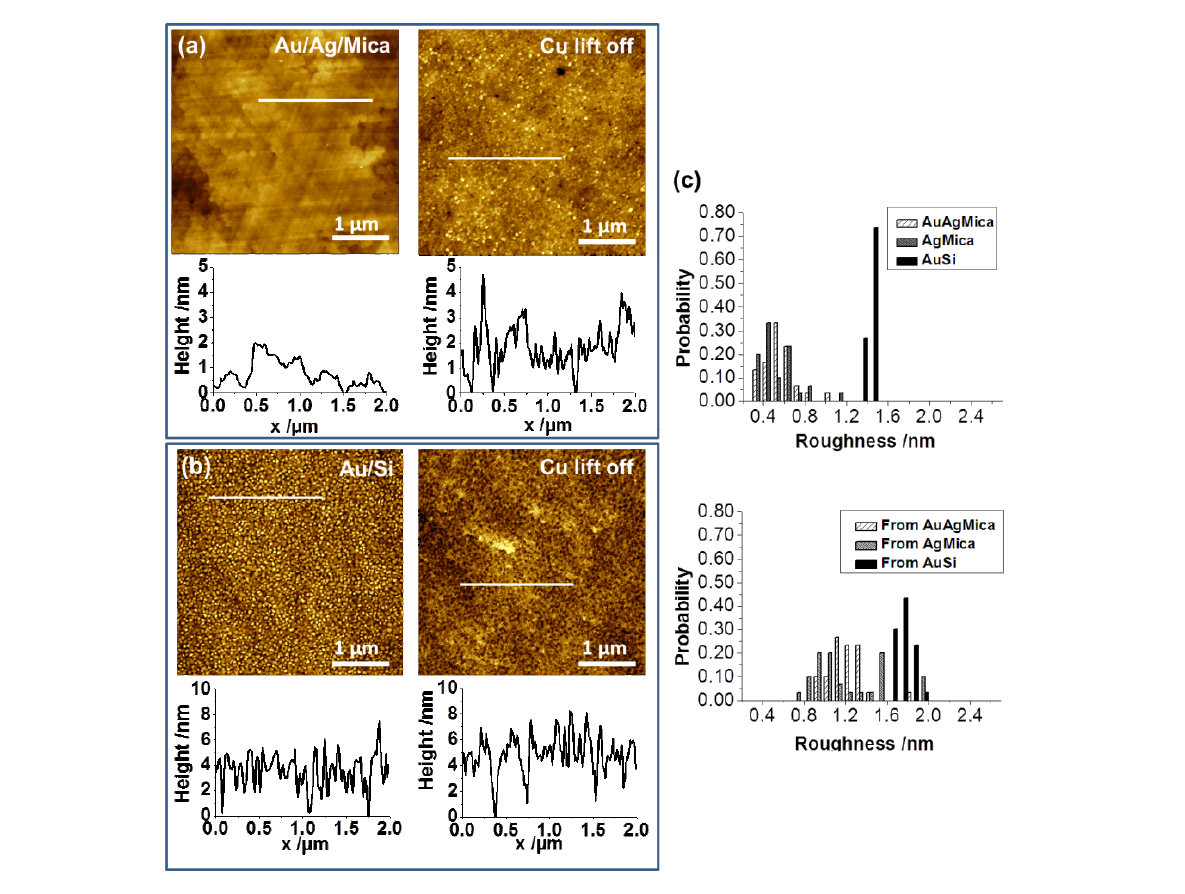
Figure 10: (a,b) AFM topography images and height profiles along the lines indicated, comparing the roughness of different substrates with the corresponding surface of the Cu film after lift-off; (a) Au/Ag/mica (b) Au/Si. Conditions for Cu deposition: − 0.8 V for 2 s and − 0.35 V. (c) Roughness histograms of substrates (top) and Cu surfaces after lift-off (bottom) from 30 measurements of areas 1 × 1 μ m 2 in size for each surface.